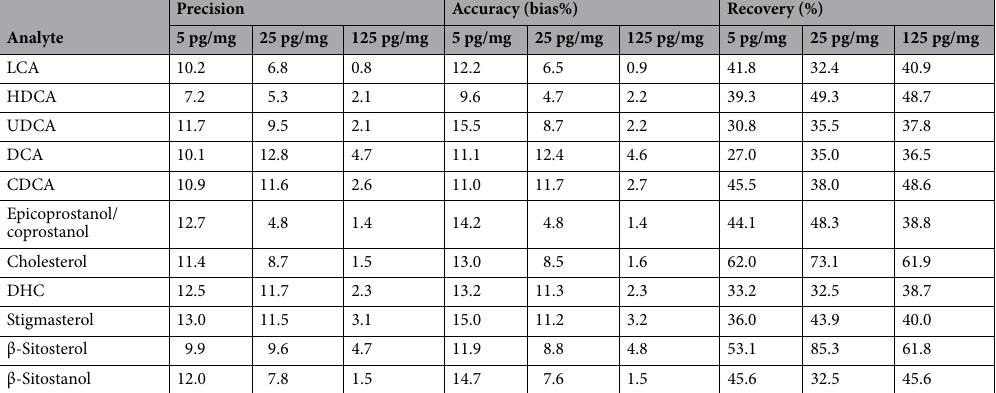
Table 4. Intra-day precision, accuracy (bias%), and recovery for each compound.